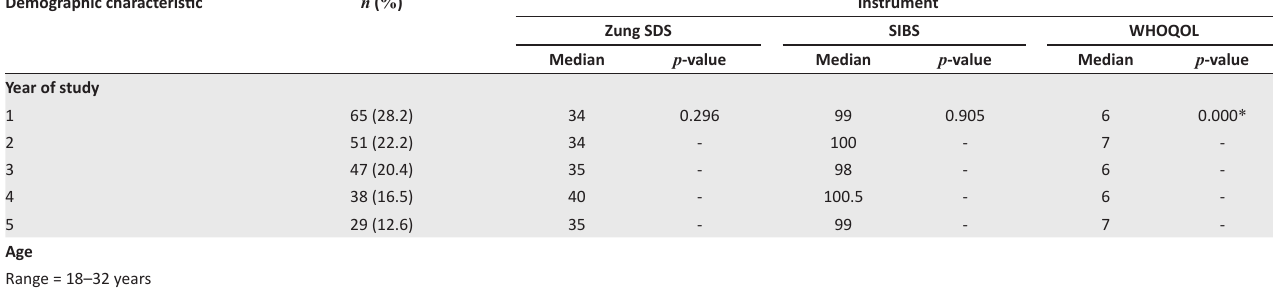
TABLE 1: Demographics and median scores on each instrument Demographic characteristic